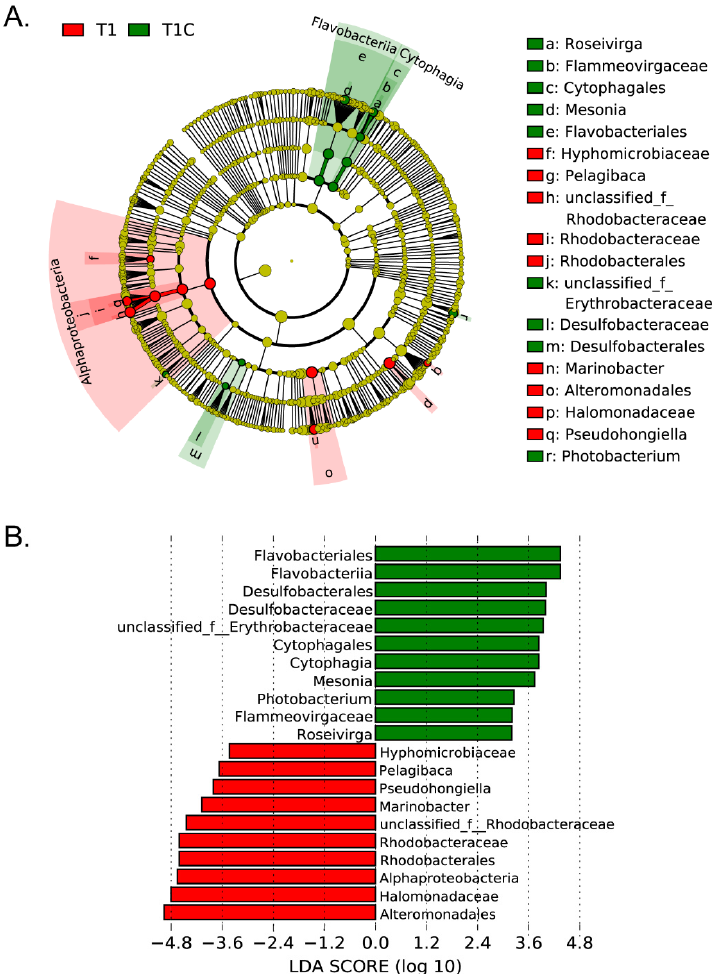
Figure 5. The results of LEfSe analysis of T1 & T1C samples. ( A ) The cladogram shows taxa from phylum to genus levels. Each circle represents a taxon at a different level, and the size of the circle is proportional to the relative abundance. Yellow-colored circles indicate taxa that are not significantly different between groups. Red and green colored circles represent taxa significantly associated with T1 or T1C, respectively. ( B ) The histogram of LDA scores indicating biomarker taxa with significant differences between T1 and T1C groups ranked by effect size.